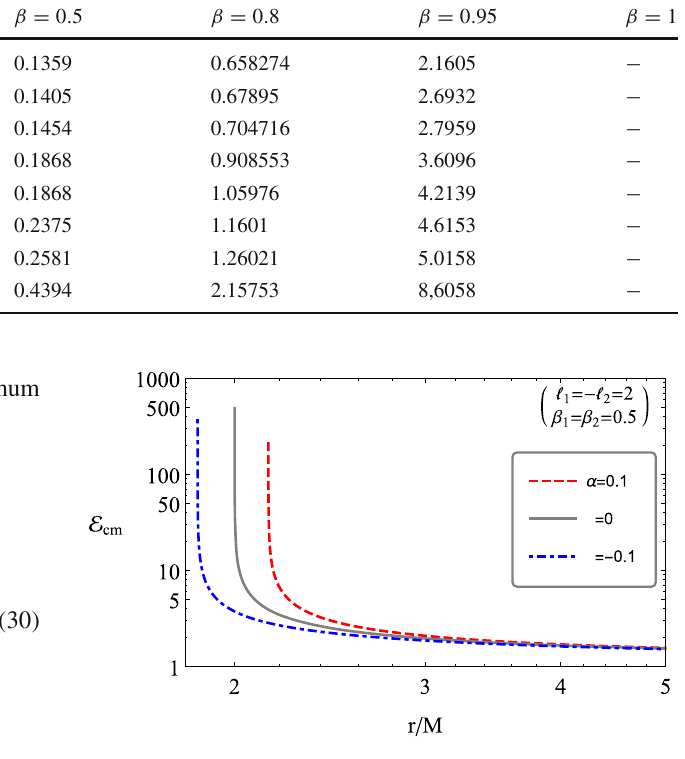
Fig. 6 The radial dependence of the center of mass energy of collision of two magnetized particles with the same initial energy E 1 = E 2 = 1, around Schwarzschild-MOG black hole for the different values of the α parameter